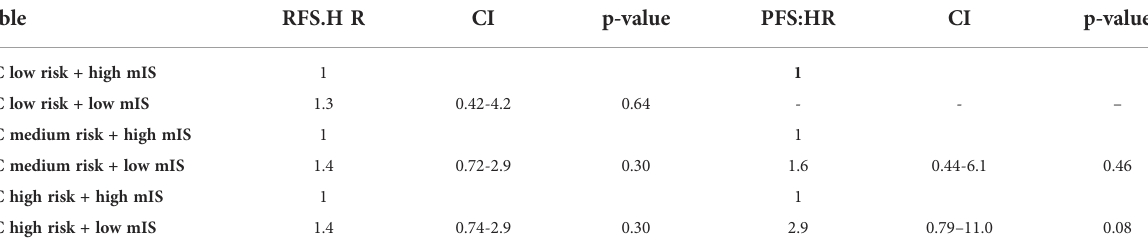
TABLE 5 EORTC-Substrati fi